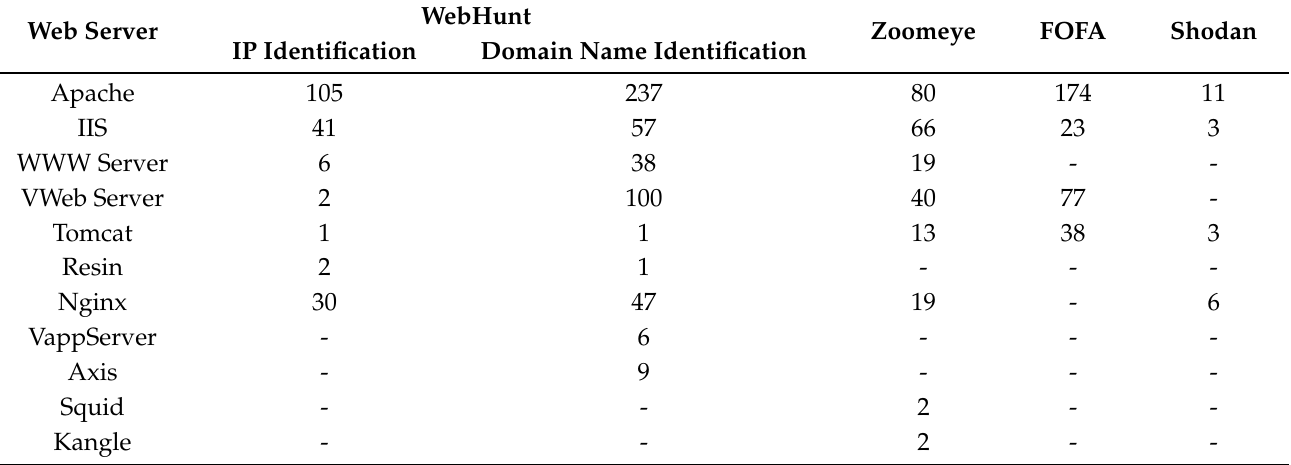
Table 13. Numbers of Web servers detected by WebHunt, Shodan, FOFA and Zoomeye. Web